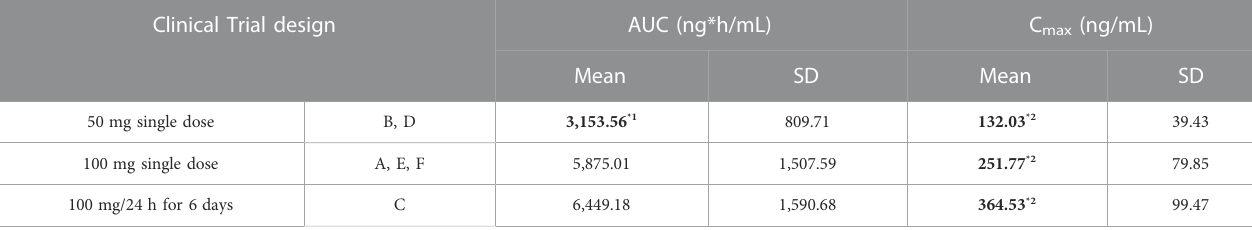
TABLE 3 Uncorrected AUC and C max values according to the study design. Clinical Trial